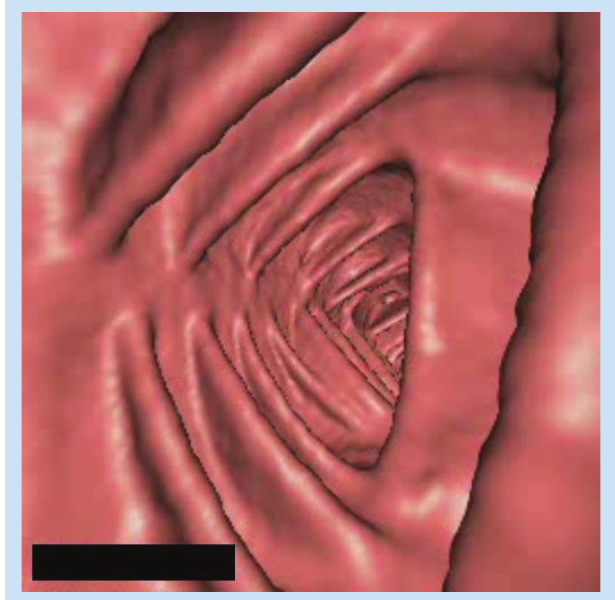
Fig. 1. Image showing change to triangular configuration from descending to transverse